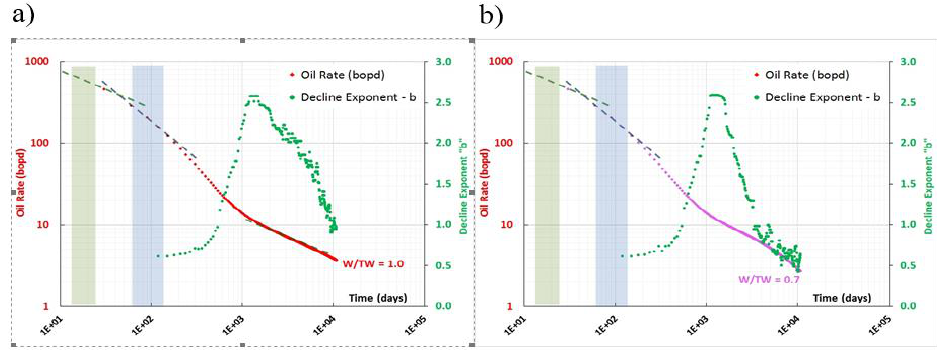
Figure 16. Analysis of b -sigmoids in log-log rate versus time plots. ( a ) W / TW = 1.0, ( b ) W / TW = 0.7. After [7]. For further details on b -sigmoids, see [17].